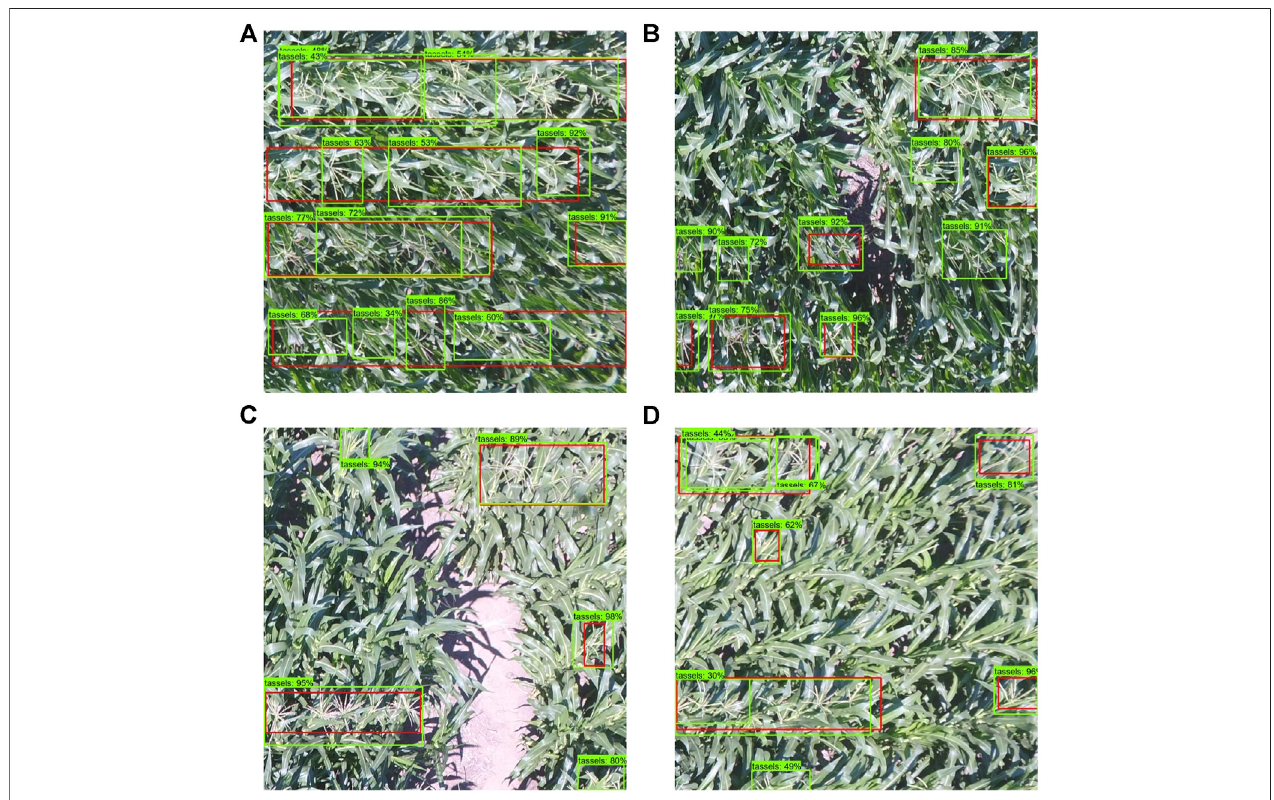
FIGURE 9 | [Best viewed in color] Visualization of the trained model output on some test UAV images. The red bounding boxes refer to the ground truth, whereas the green bounding boxes refer to the model detection. Notice in (b), (c), and (d) that there are unlabeled tassels which were detected by the model.